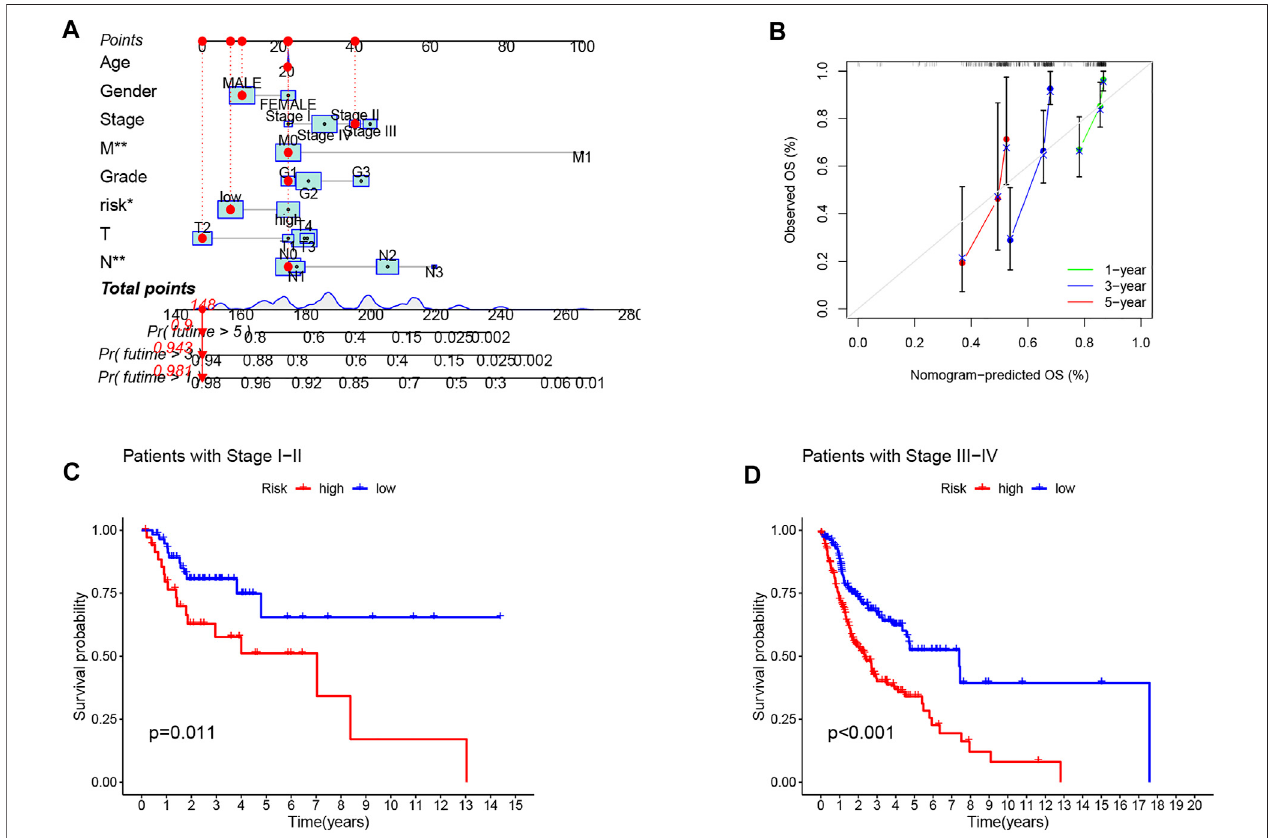
FIGURE 5 | Construction and evaluation of a nomogram based on CRLPM. (A) nomogram used to predict prognosis was constructed based on CRLPM. (B) calibrationcurvesareusedtopredict1-,3-,and5-yearoverallsurvival. (C) Kaplan – MeiercurvesofpatientswithstageI-II. (D) Kaplan – Meiercurvesofpatientswithstage III –